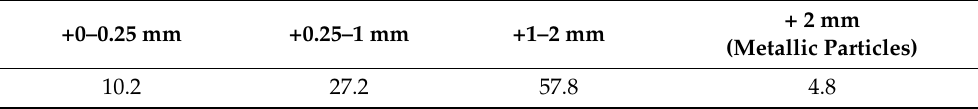
Table 2. Mass balance of the crushing down to 2 mm